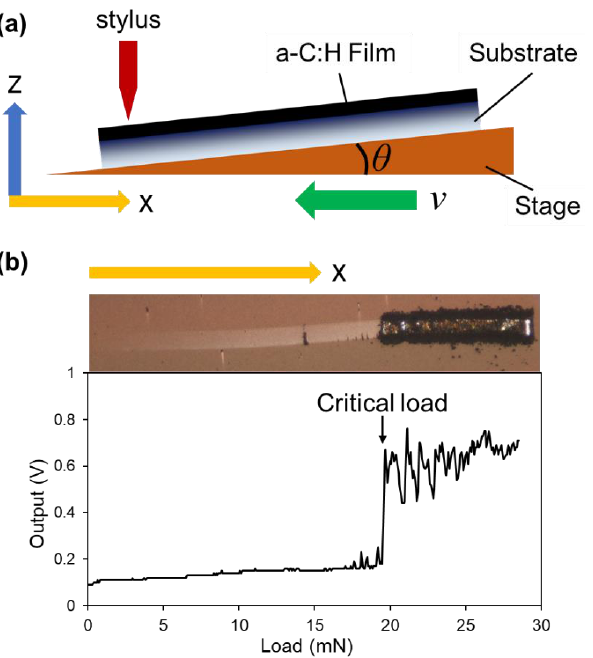
Figure 4. ( a ) Schematic diagram of micro-scratch test and; ( b ) optical microscope image of the film tested and a typical response obtained from the micro-scratch test. (Color does not need to be used.).